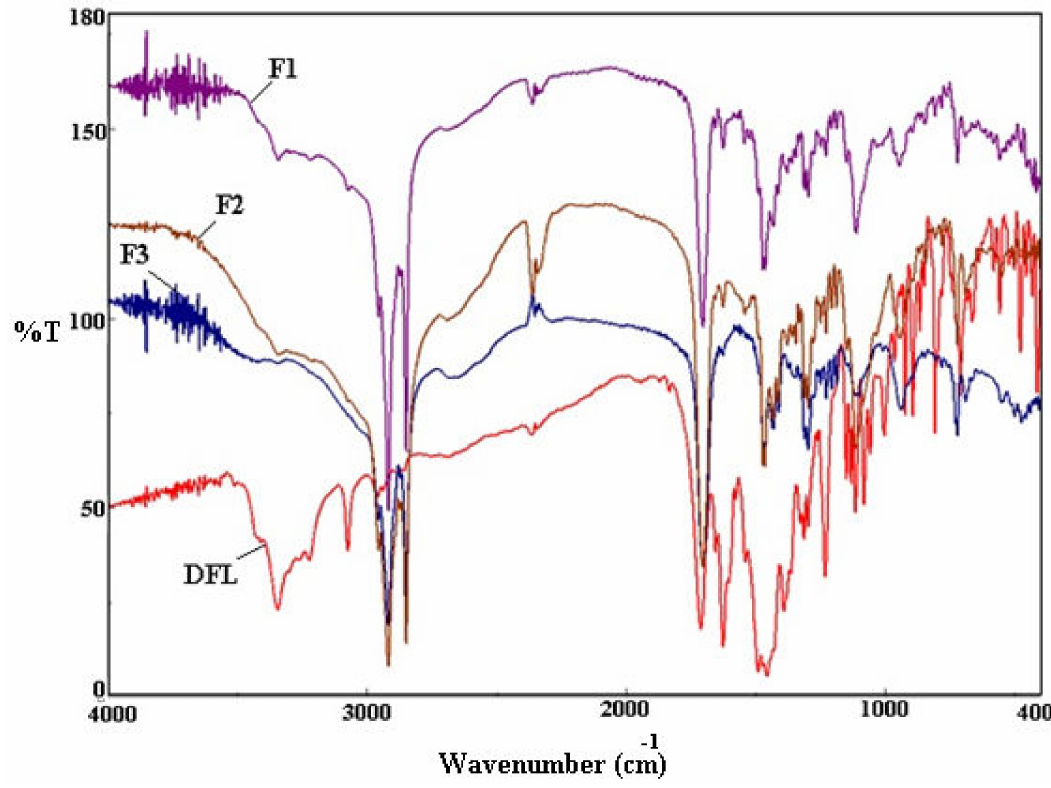
Figure 2. A comparative Fourier transform infrared (FTIR) spectra of pure DFL and DFL-loaded L-P-NPs